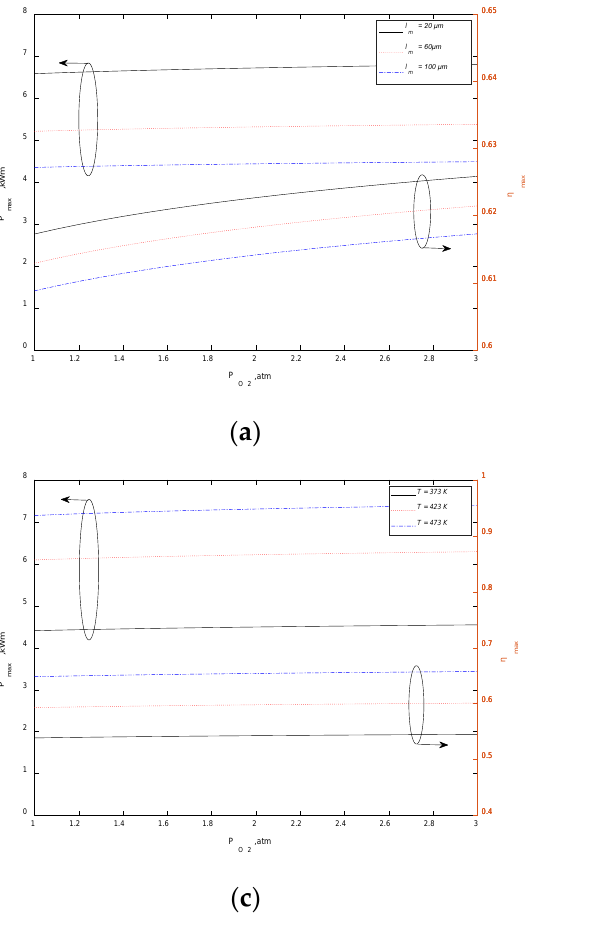
Figure 6. Effect of operating temperature on P max and η max of HT-PEMFC under different parameters. ( a ) Different l m ; ( b ) different X ; ( c ) different T; ( d ) different p H